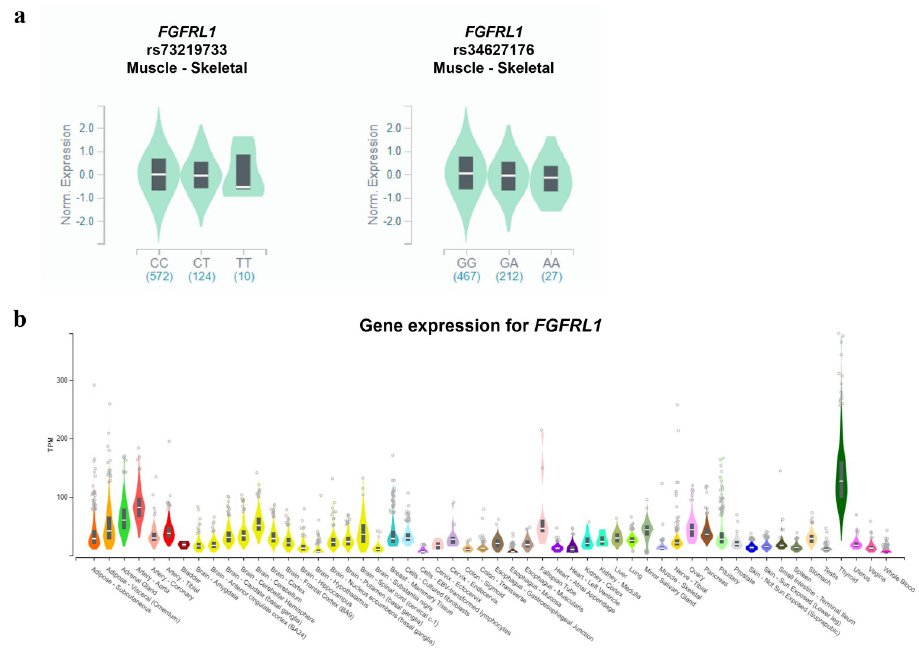
Fig 2. FGFRL1 gene expression and identification of three SNPs in eQTL. Each genotype in skeletal muscle is expressed using GTExPortal. (a) Expression of rs73219733 and rs34627176 in FGFRL1 . The two SNPs showed lower expression in their minor allele with statistical significance reaching P < 10 − 4 . (b) Expression of the FGFRL1 gene.